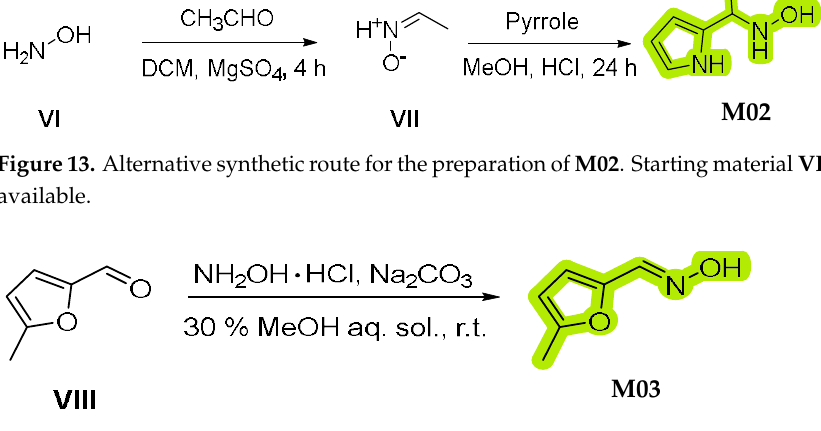
Figure 14. Traditional method for the preparation of compound M03 . Starting material VIII is commercially available. Figure 15. Alternative synthetic route for the preparation of compound M03 . Starting material IX is